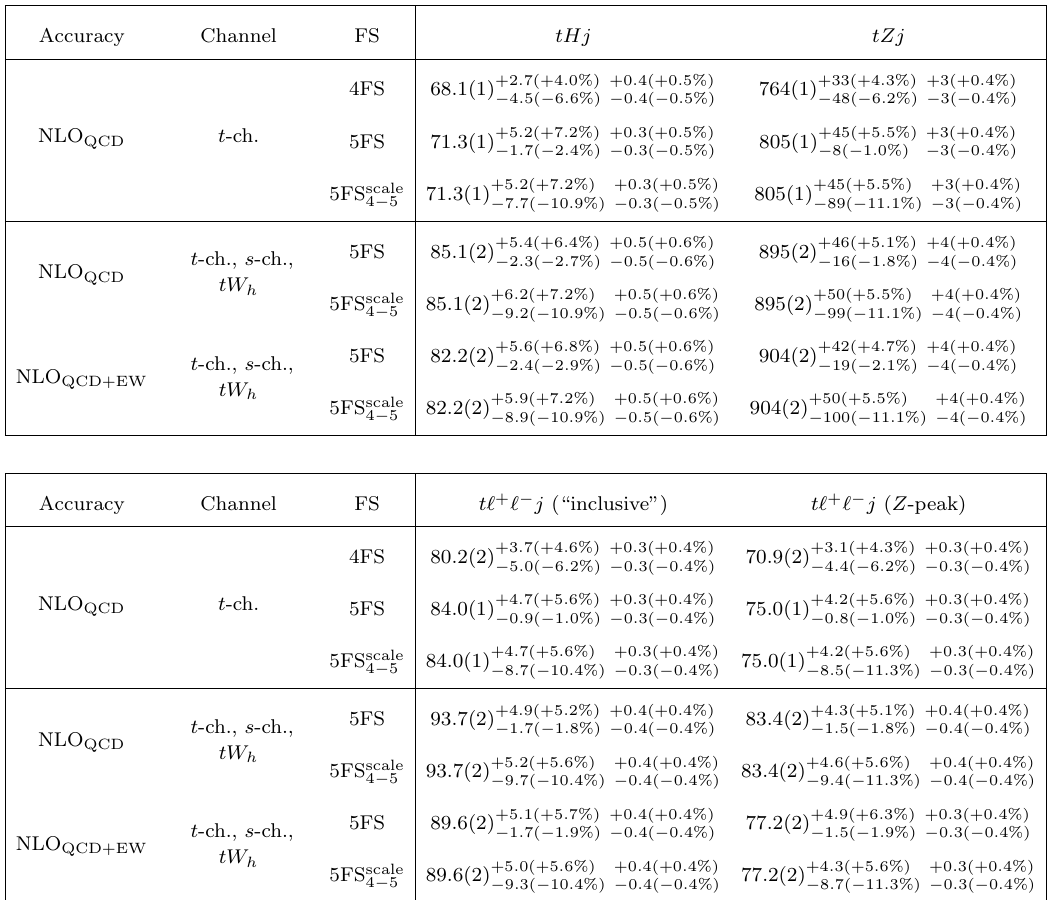
Table 1 . Total cross-section for tHj , tZj and t‘ + ‘ (cid:0) j production. The uncertainties are scale and PDF of the form (cid:6) absolute ( (cid:6) relative in %). The (cid:12)rst number in parentheses after the central value is the absolute statistical